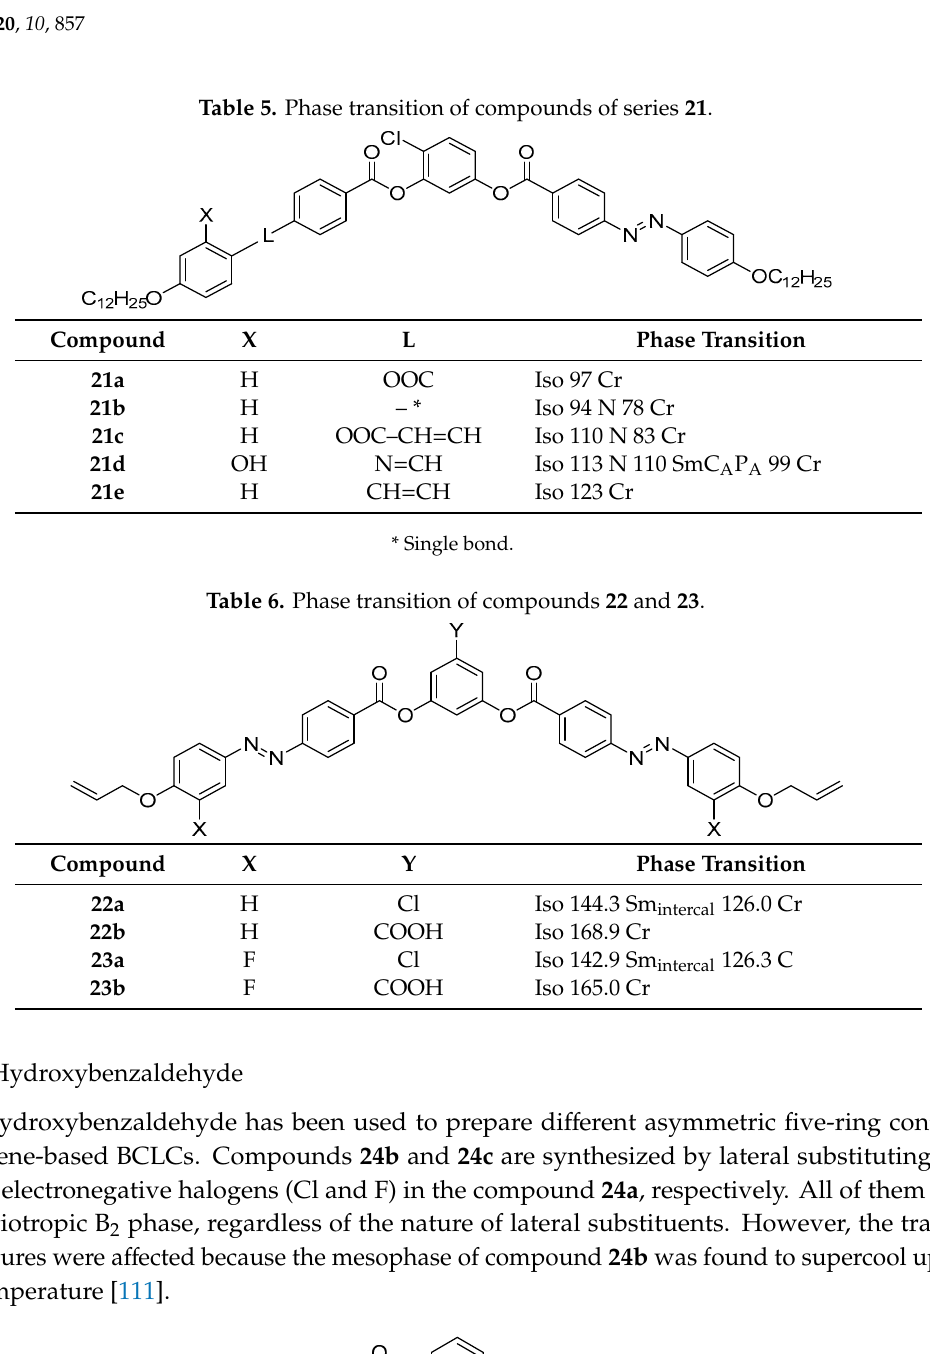
Figure 6. Optical texture for 20b in ( a ) the nematic phase at T = 90 °C and ( b ) the unidentified SmC x